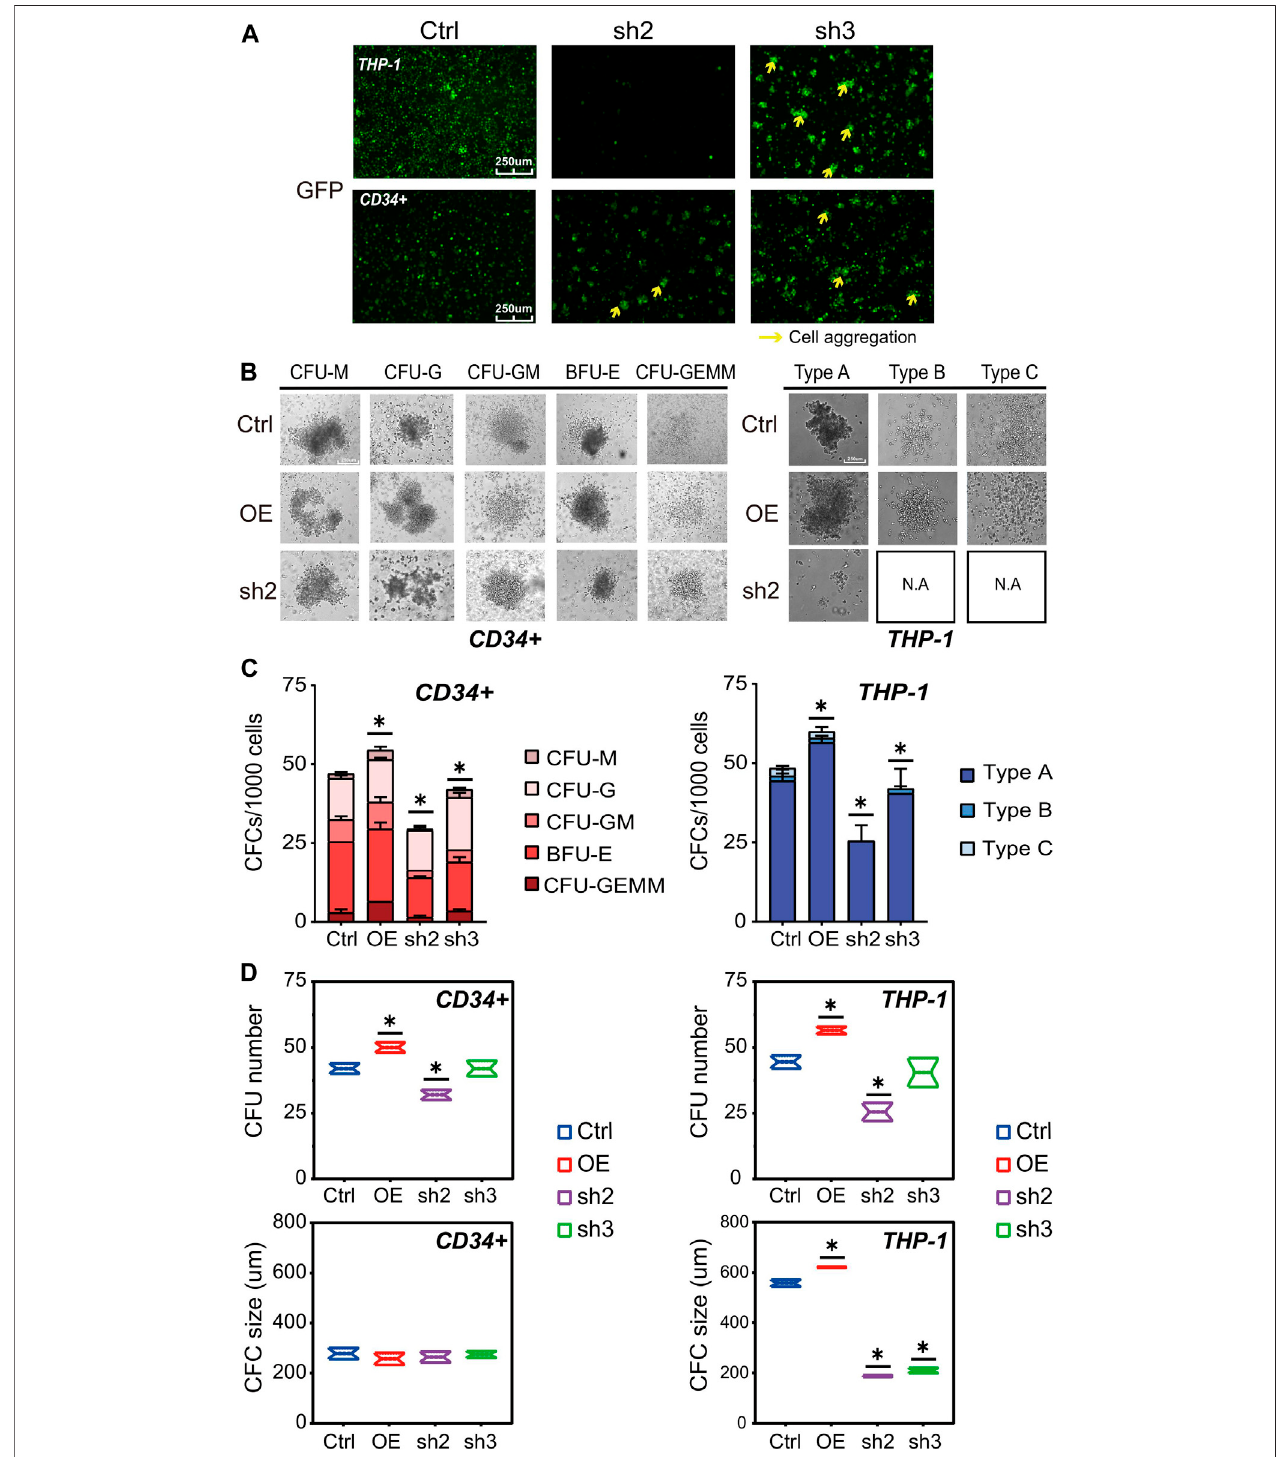
FIGURE 3 | RUNX1 knockdown may affect leukemia cell differentiation ability. (A) Cell morphology change and cell aggregation in cell culture at day 5. (B) Colony formation of human THP-1 cells and CD34 + cells after transduction of empty vector, RUNX1 and shRUNX1. The colony morphology could be observed at (B) and the wholecolonynumberand subtypecalculatedat (C) ,colonynumber (upper)and colonysize(lower)wererespectivelyanalyzed at (D) .(one-way ANOVA,* p < 0.05, ** p < 0.01,*** p < 0.001; error bars, median ± SD).